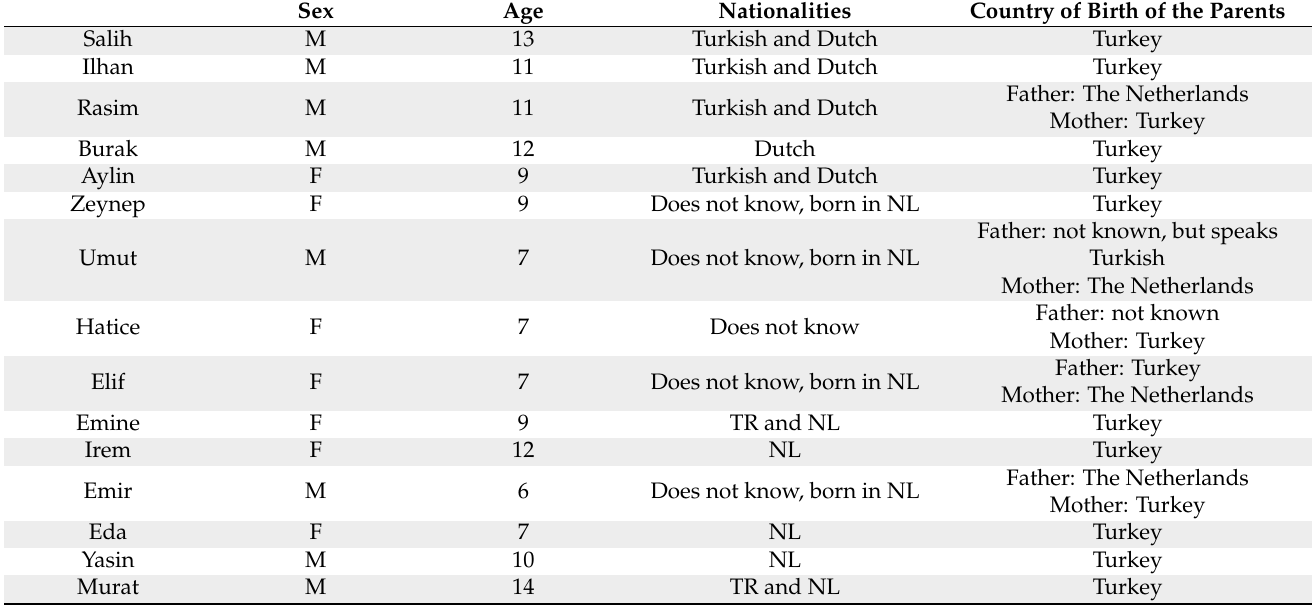
Table 2. Demographic characteristics of the students at the Milli Görü¸s